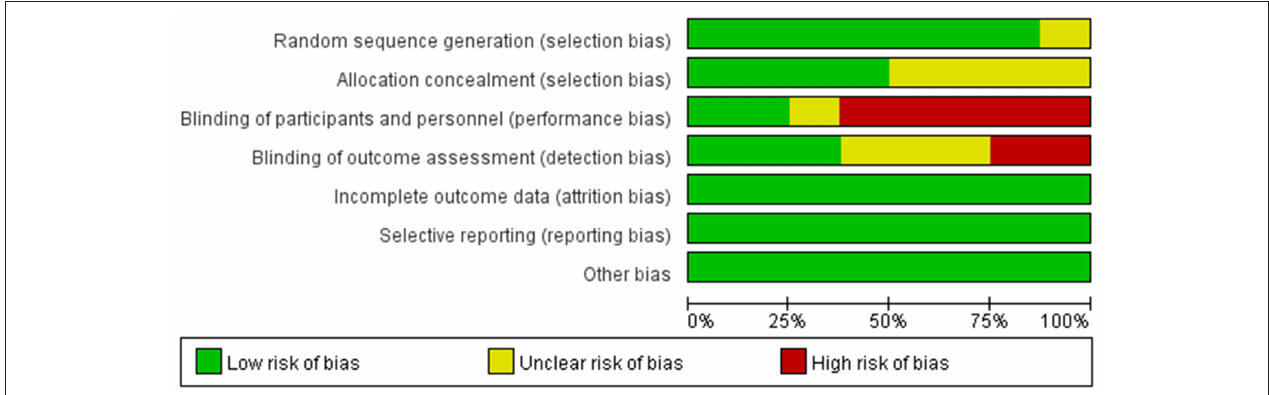
FIGURE 3 | Authors’ judgments about each risk of bias item presented as percentages across all included